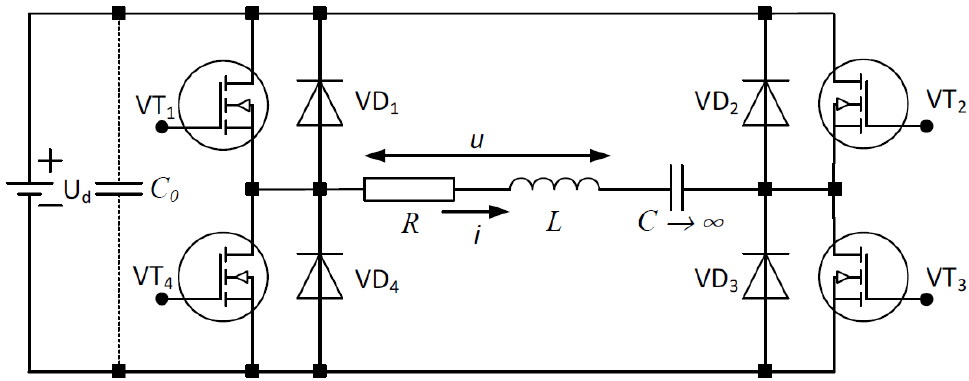
Figure 1. Full-bridge series RLC inverter.